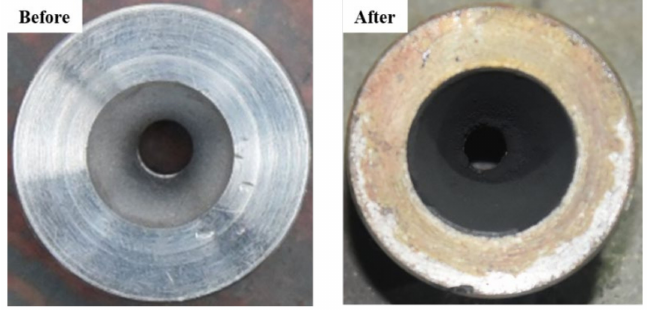
Figure 9. Topography of the throat changes before and after the